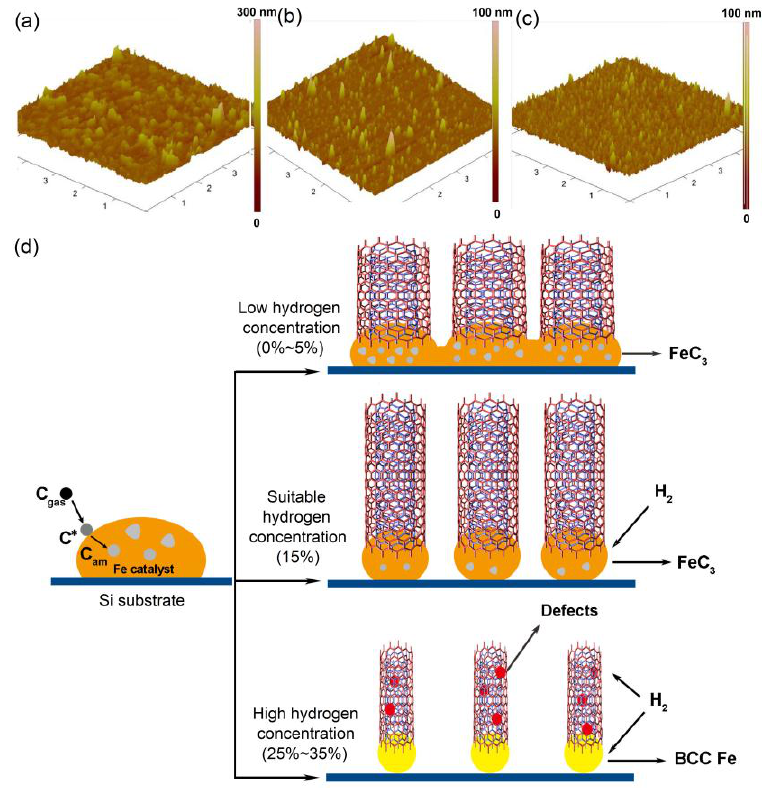
Figure 5. Atomic force microscopy (AFM) analysis of catalyst surface after chemical vapor deposition (CVD) process under different H 2 concentrations: ( a ) 5%; ( b ) 15%; ( c ) 35%. ( d ) The influential mechanism model of hydrogen concentration on the structure of VACNTs.